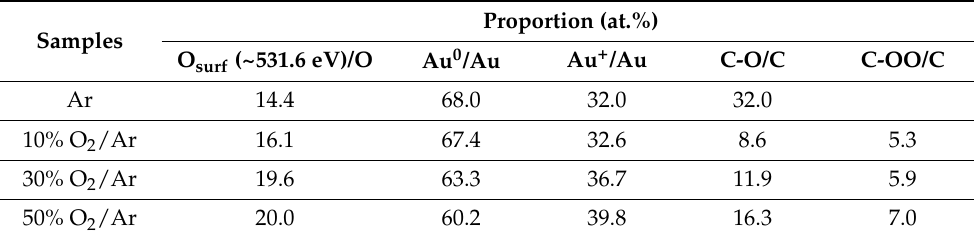
Table 1. XPS analysis of the Au/TiO 2